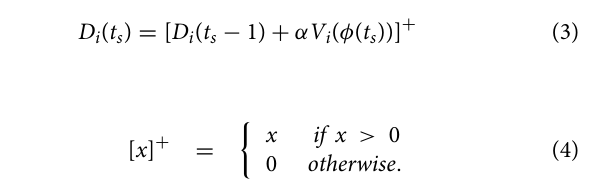
structures (Pr-Ph). An action is associated with this PC. This association is learned by a least mean square algorithm. Then, the system automatically moves in the learned direction when the associated PC wins. (B) Activity of 3 visual place cells recorded on a linear track in a real outdoor environment. The different maxima of activity correspond to the learned positions of the associated cells. Our architecture provides good generalization properties since activities present large place